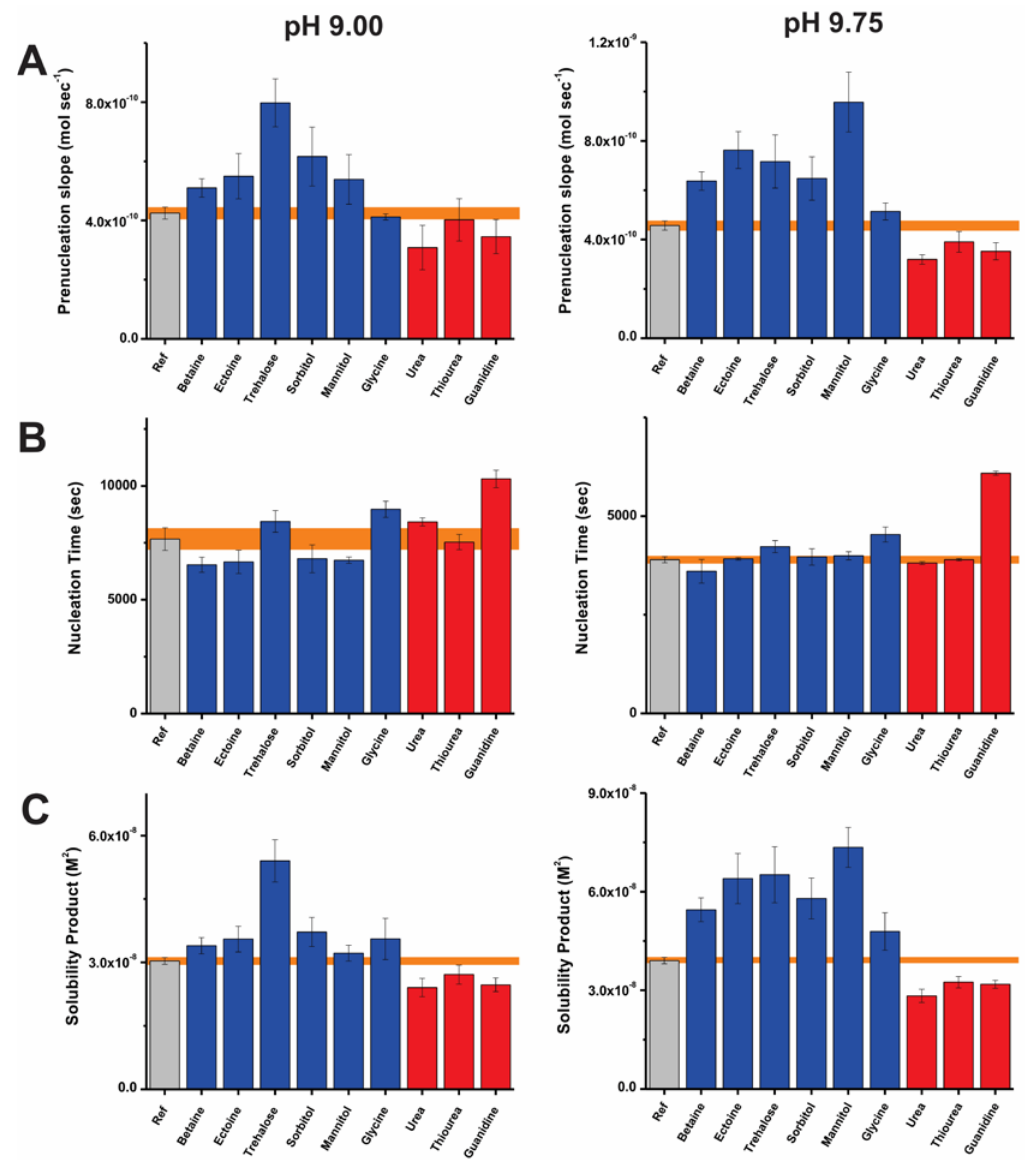
Figure 2. Bar plots representing the early stages of CaCO 3 nucleation in terms of the ( A ) pre-nucleation slope, ( B ) time required for nucleation and ( C ) solubility of initially nucleated phase at pH 9.0 (left) and 9.75 (right) in the presence of kosmotropic (blue) and chaotropic (red) additives and also in reference (Ref, gray) experiments. Error bars depict ± one standard deviation and corresponding values for reference experiments are shaded (orange).